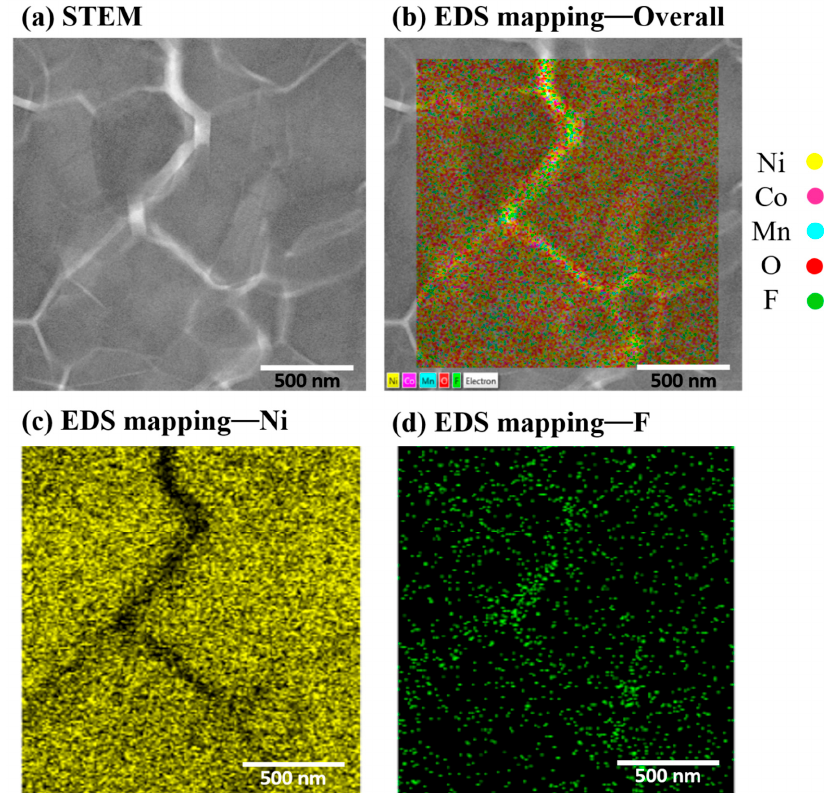
Figure 5. STEM images and the corresponding energy dispersive spectroscopy (EDS) mapping results for NCM811 after 600 cycles at 45 ◦ C: ( a ) STEM image of the microcracks, and EDS mapping images of for NCM811 after 600 cycles at 45 °C: ( a ) STEM image of the microcracks, and EDS mapping images ( b ) overall, ( c ) Ni, and ( d ) F of ( b ) overall, ( c ) Ni, and ( d ) F species.